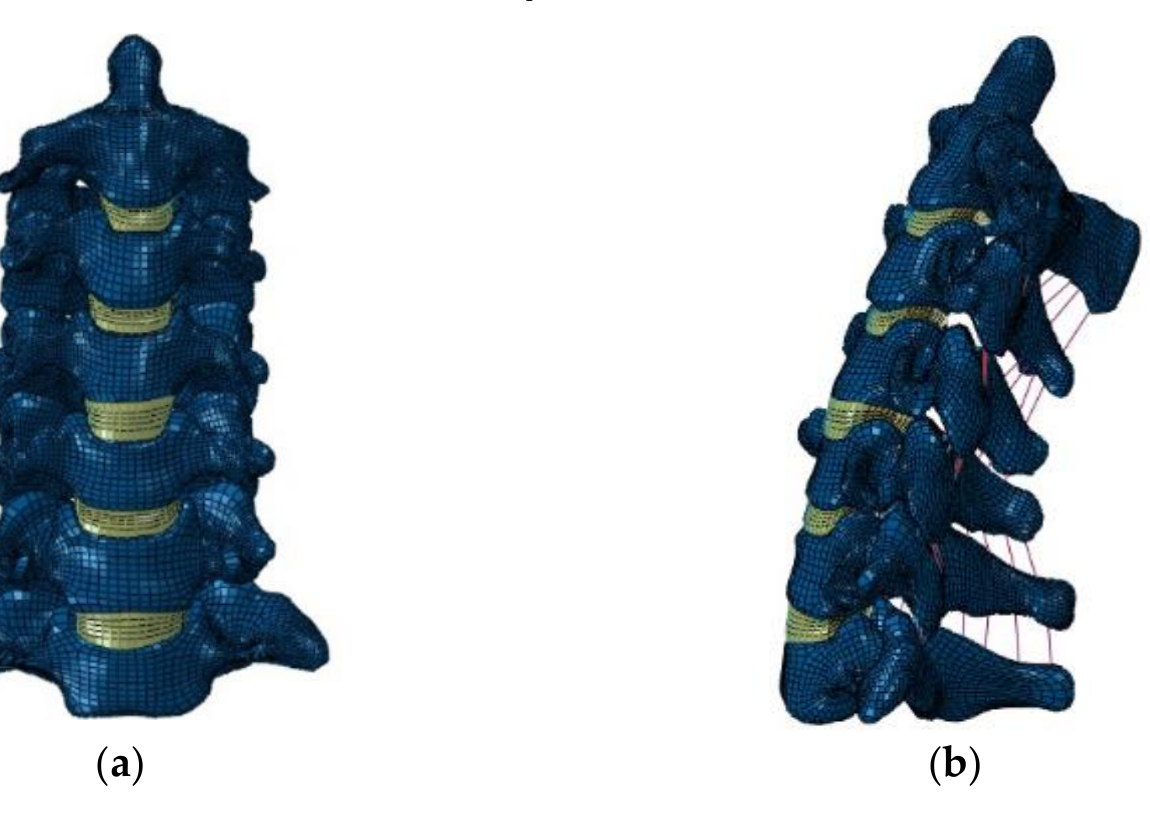
Figure 1. Finite element (FE) model of intact cervical spine segments C2–C7: ( a ) coronal view; ( b ) sagittal view.